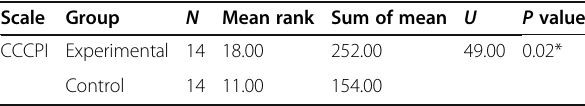
Table 5 Findings obtained from the Mann-Whitney U post-test in the experimental and control groups Scale Group